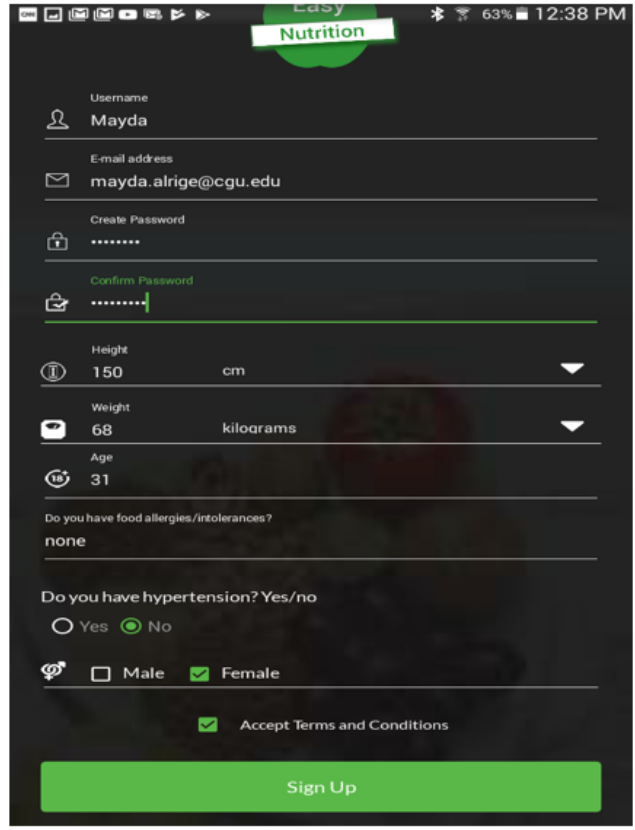
Figure 2. EasyNutrition Sign up